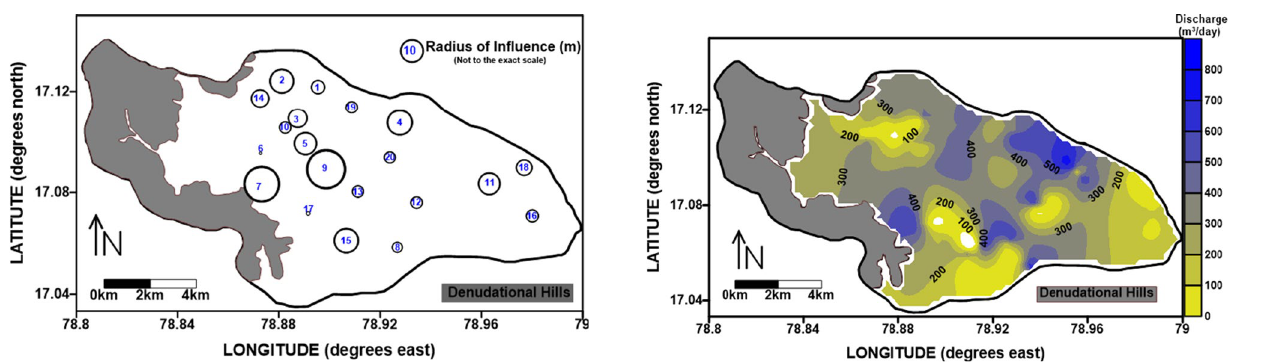
Fig. 8 Map showing the contour pattern with interval (100 m 3 /day) of measured discharge (m 3 /day) from different wells